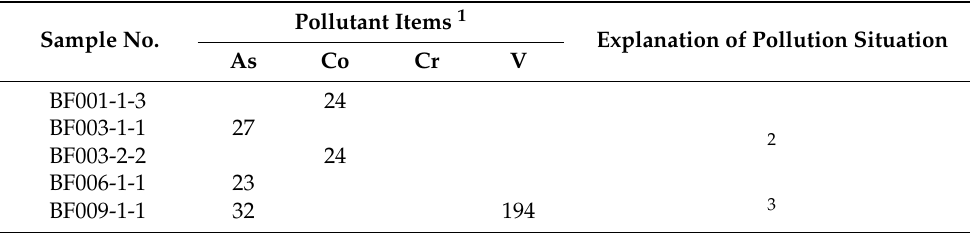
Table 5. Screening values and control values for the risk of heavy metal contamination of soil on construction